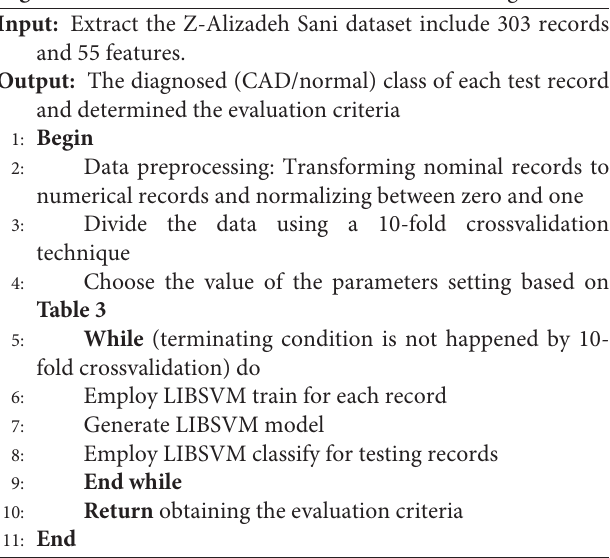
Algorithm 2 : The used LIBSVM method for CAD diagnosis.